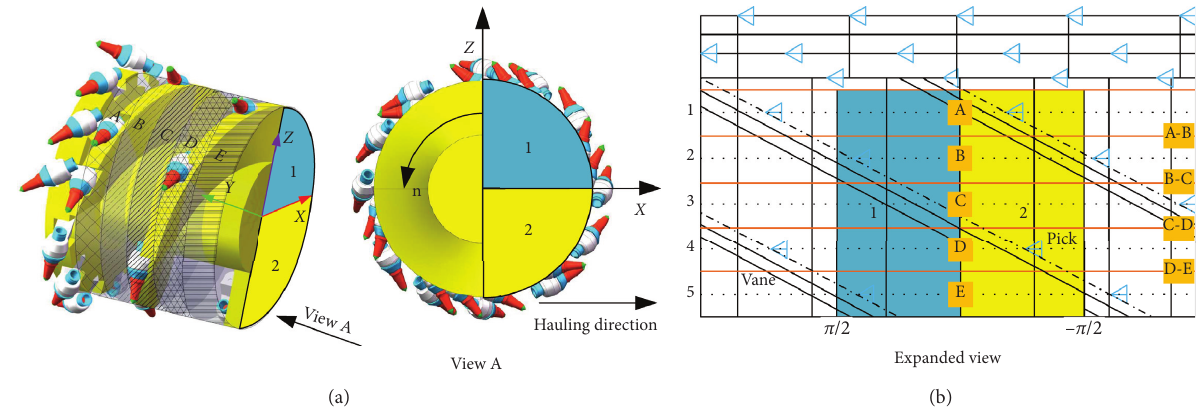
Figure 6: The statistical zone of the drum with different web depths. (a) View A. (b) Expanded